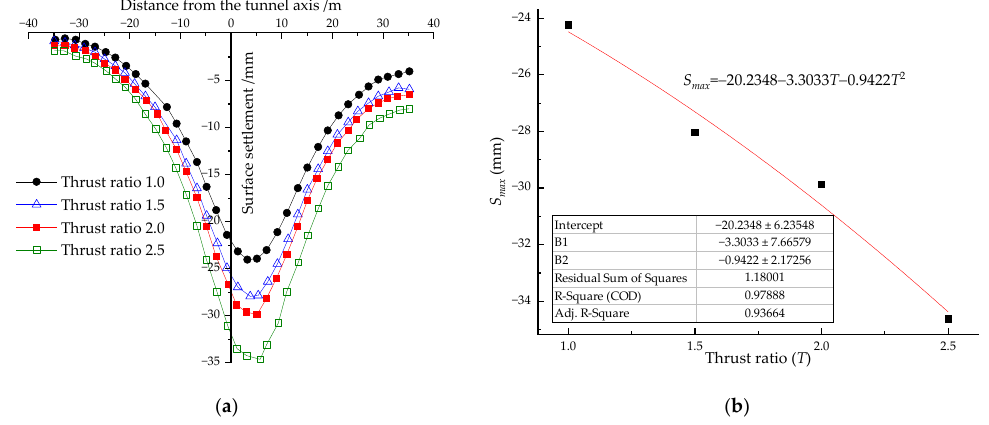
Figure 7. Surface settlement under various thrust ratios: ( a ) curves of surface settlement; ( b ) maxi- mum surface settlement with various thrust ratios.